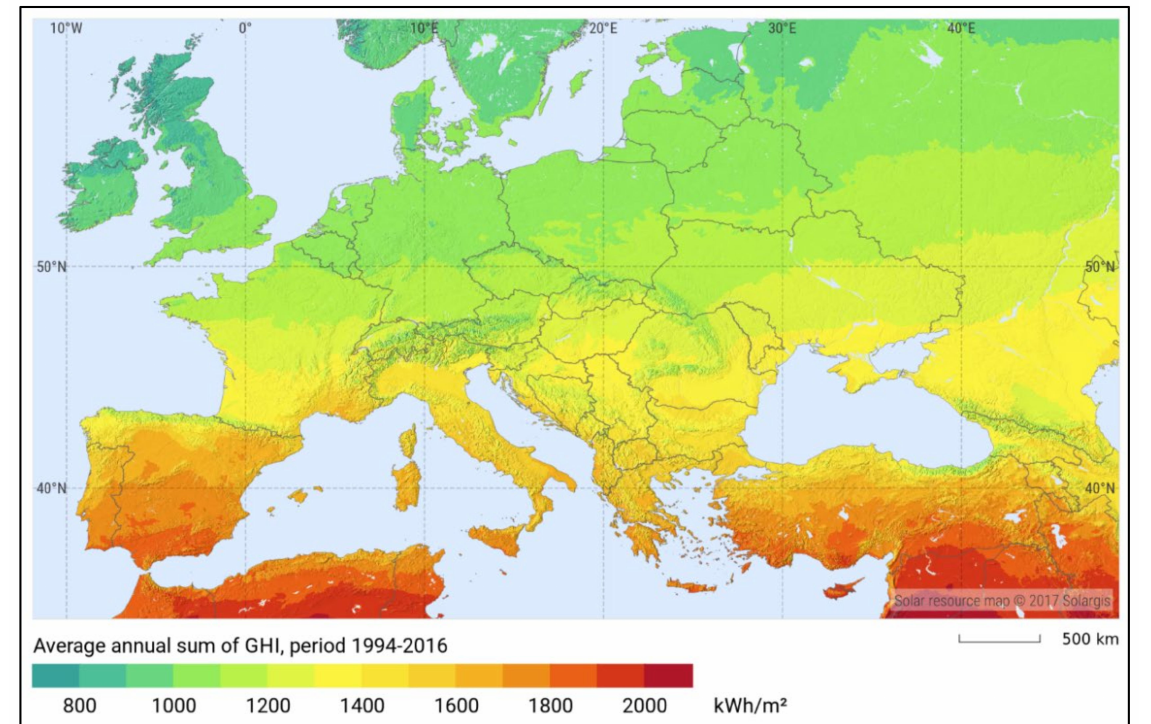
Figure 5. The theoretical solar incident radiation potential map of BIPV in Europe